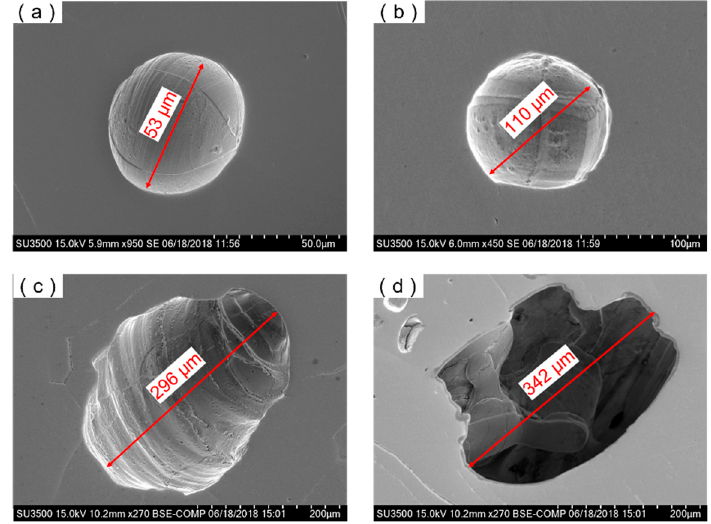
Figure 9. Typical size and shape of pores in laser welding NS-Mo alloy joints produced under: ( a , b ) heat input 250 J/cm; ( c , d ) heat input 3600 J/cm.